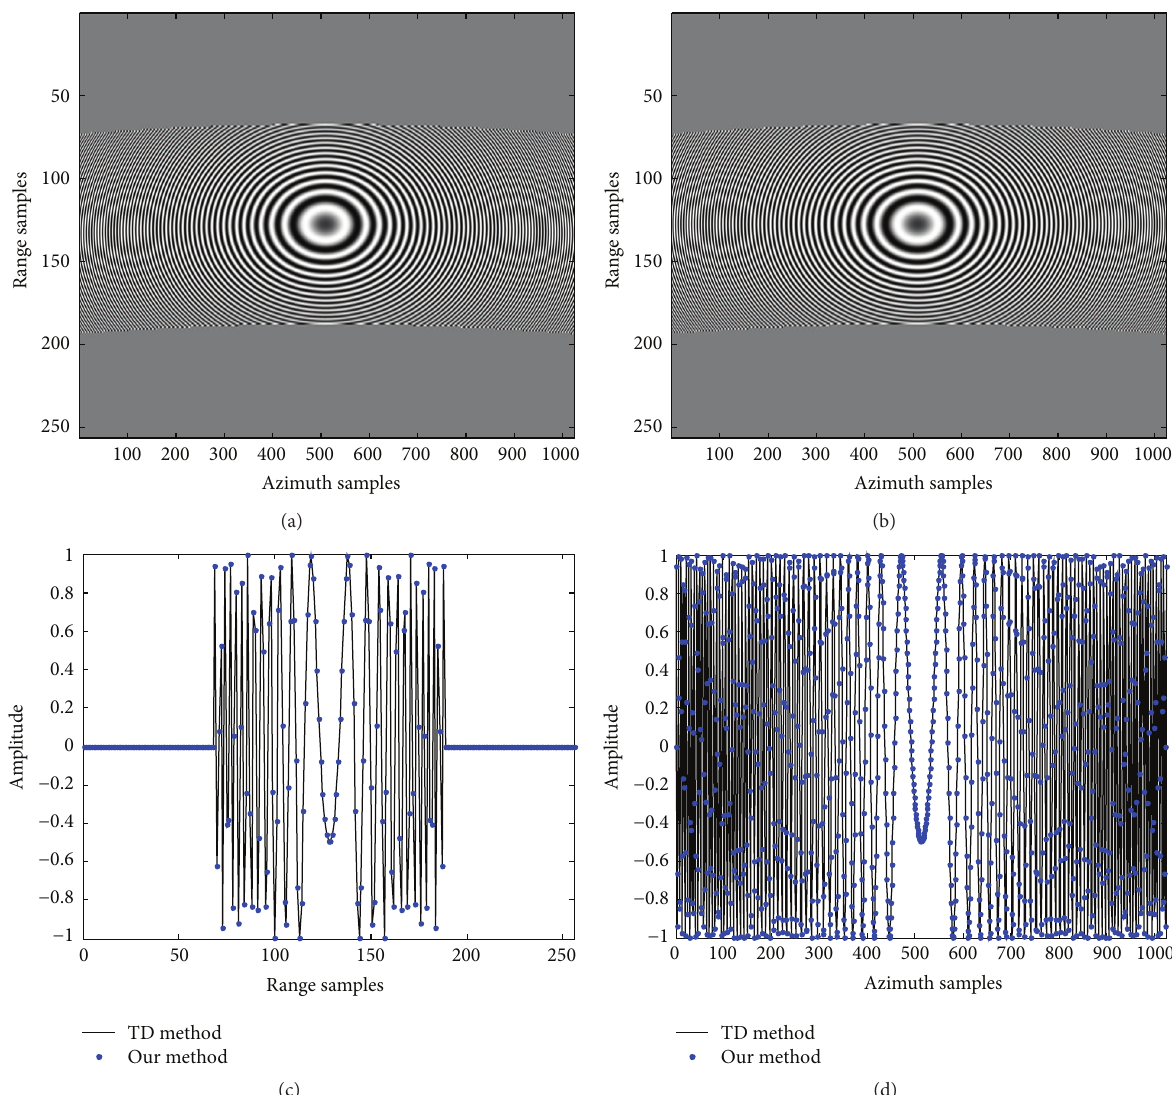
Figure 8: Simulated SAR raw data using different methods: (a) TD method; (b) our method; (c) range cut; (d) azimuth cut.